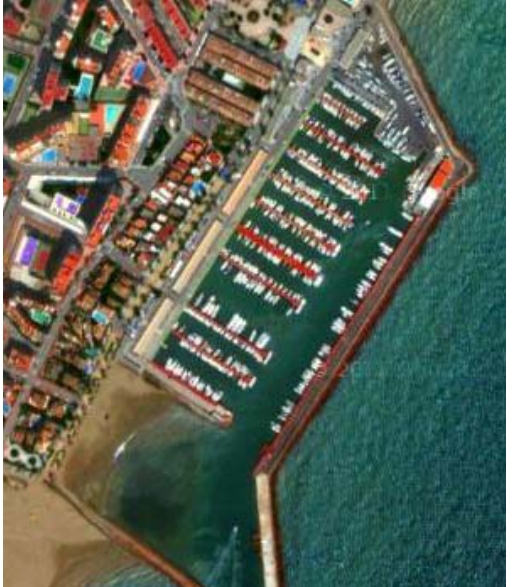
Figure 10. Aerial view of the small marina experimental